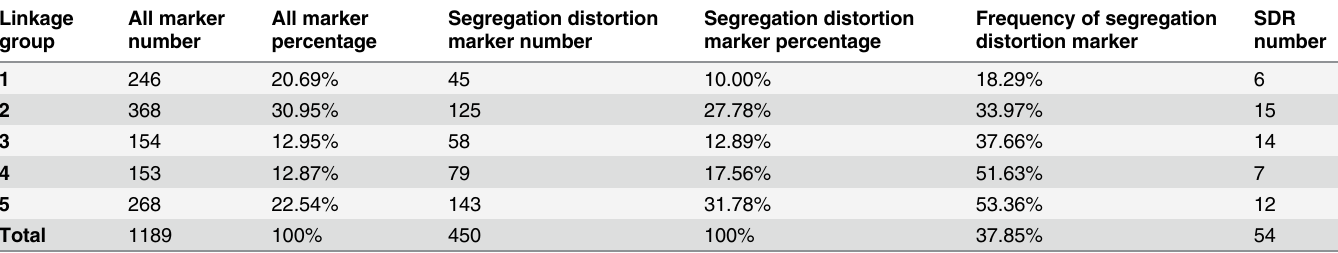
Table 6. Distribution of segregation distortion markers on the five linkage groups.